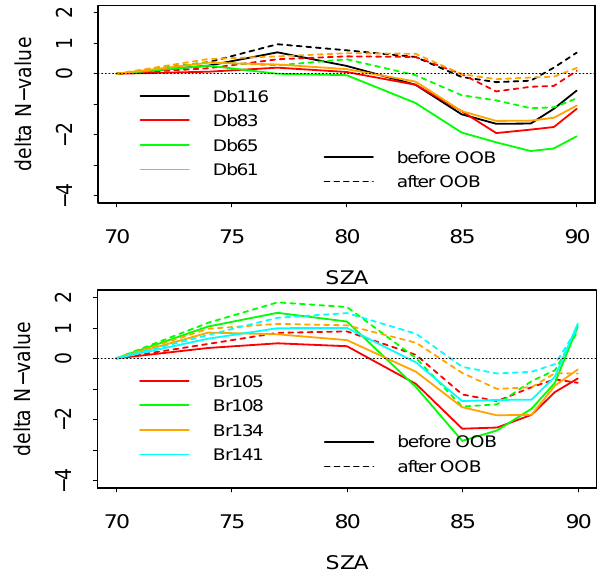
Fig. 5. Difference between observed and simulated Umkehr N- values as function of SZA. Solid and dashed lines represent Umkehr simulations prior and after stray light corrections (OOB) respec- tively. The Umkehr observations were recorded on 20 Septem- ber 2007 in Boulder, CO and at the Table Mountain Test Facility located near Boulder, CO. (a) Results are demonstrated for Dob- son Umkehr measurements taken by NOAA instruments #83, 61 and 65, and by JMA Dobson # 116; (b) the same as (a) , but for Brewer Mark IV instruments that perform routine measurements as part of the NEUBrew network (instrument numbers are given in the